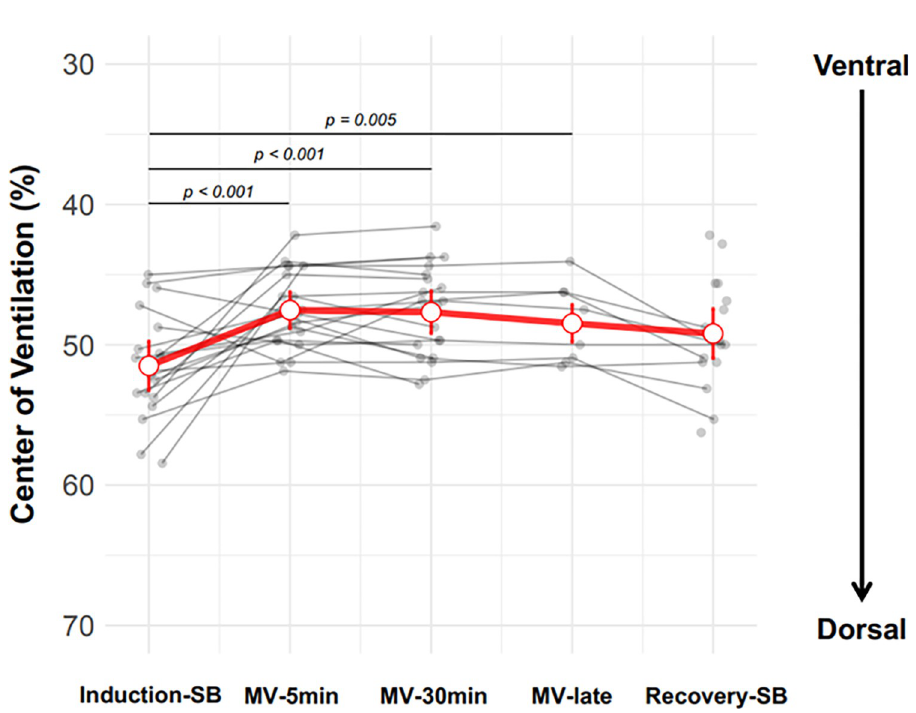
Fig 3. Distribution of pulmonary ventilation assessed by center of ventilation (CoV) presented over the five time points: Induction-SB, MV-5min, MV-30min, MV-late and recovery-SB. The CoV is a parameter that quantifies the distribution of ventilation. When we have a value of 50 it means that ventilation is equally distributed between the anterior and posterior regions of the thorax. Higher numbers indicate a shift towards the dorsal region, and lower numbers indicate a shift towards the ventral region. Significant variations were observed in the ventilation distribution measures demonstrated in percentage when compared MV-5min, MV-30min and MV-late to induction-SB.